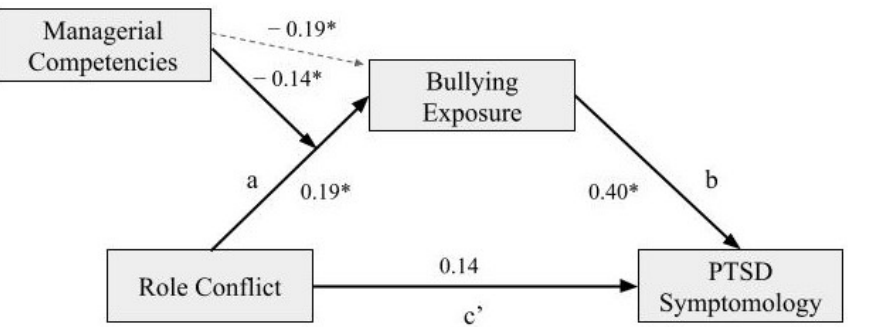
Figure 4. Coefficients of the moderated mediation model with neuroticism as a moderator. Note. * indicates p < 0.05. c’ (c-prime) refers to the direct effect.